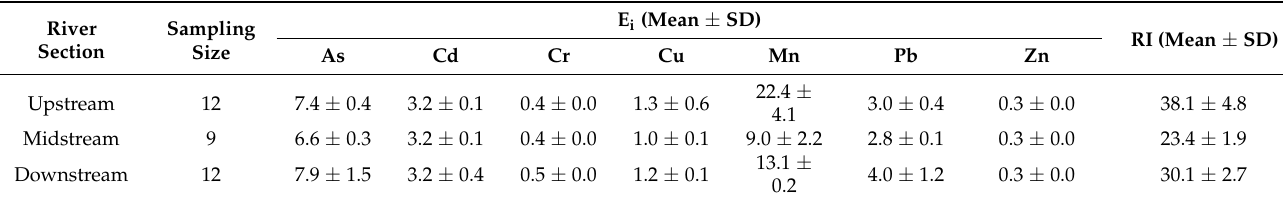
Table 6. Potential ecological risk posed by individual PTE (E i ) and multiple PTEs (RI) in the river sediments. River Sampling Section